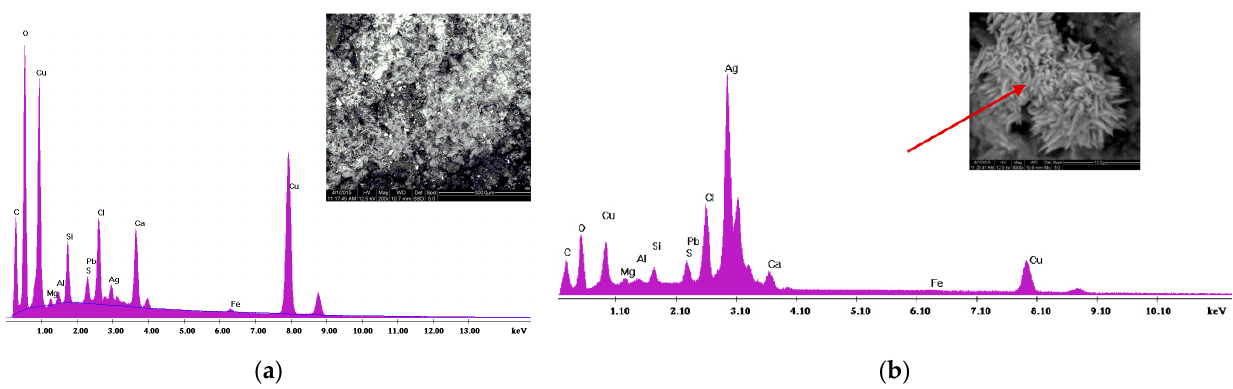
Figure 6. SEM image and EDX analysis: ( a ) Corroded surface magnified by 200×—Area 1, the presence of Ag corresponds to the brighter spots; ( b ) A needle-shaped formation on the corroded surface magnified by 6000× and elemental analysis spectrum of the spot—Spot 1 (red arrow). Table 3. EDX chemical elemental analysis of the corroded surface of a fragment of the artifact No. 10816 at multiple spots and areas (wt%).